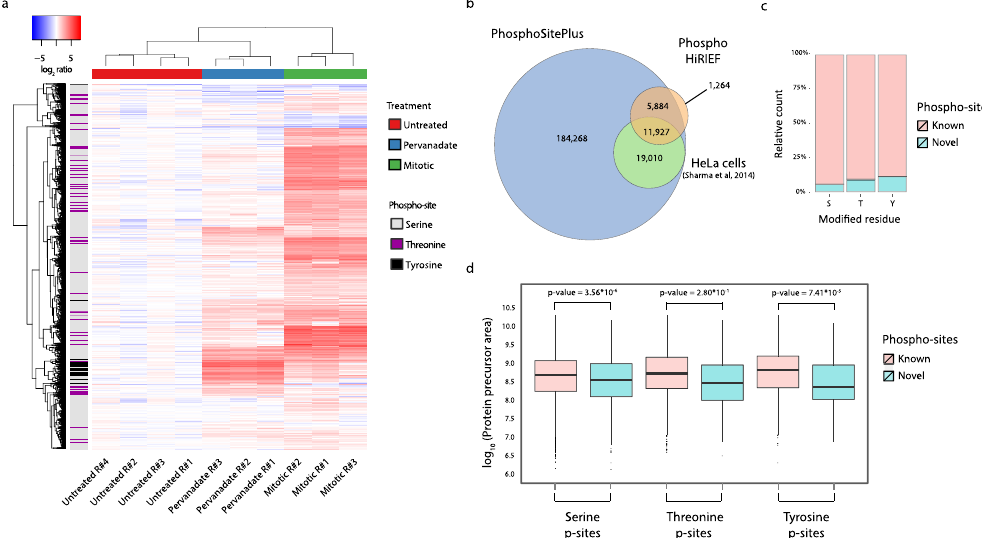
Figure 3. Functional characterization of the identified phospho-sites. ( a ) Heatmap representing complete linkage hierarchical clustering based on Euclidian distance of the unique phospho-site ratios. Row color-coding represents the modified residue (S,T or Y). ( b ) Venn diagram showing the overlap between the identified phospho-sites, the ones previously reported in the PhosphoSitePlus database and the HeLa phospho-sites reported by Sharma et al. in 2014. ( c ) Proportion of novel and known phospho-sites per modified residue. ( d ) Distribution of protein precursor areas for the novel and known phospho-sites per type of modified residue. Two-sided t-test was performed to assess